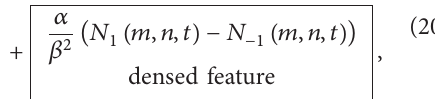
density area in the decomposed image which ensures